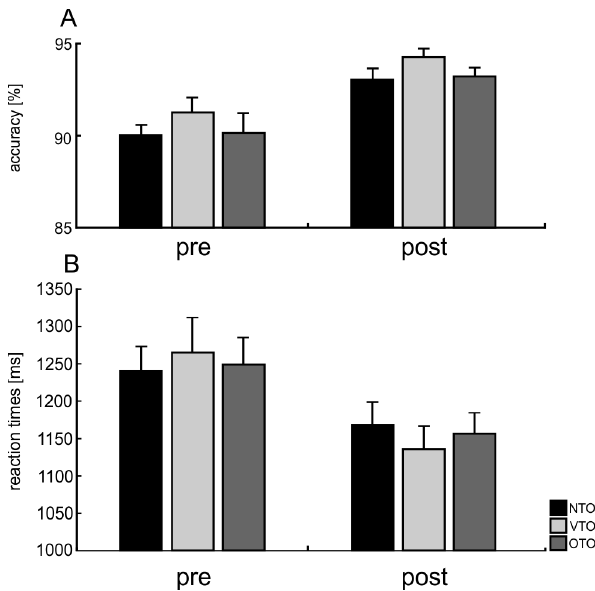
Figure 3. Mean accuracy and reaction times in the visual matching tasks before and after training. Error bars indicate standard error of mean.